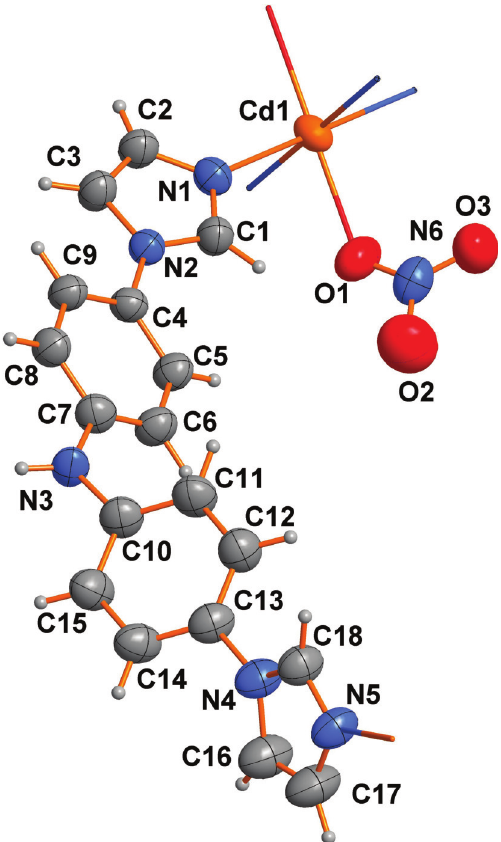
Apartofthemolecularstructureisshowninthefigure.Table1 contains crystallographic data and Table 2 contains the list of the atoms including atomic coordinates and displacement parameters.